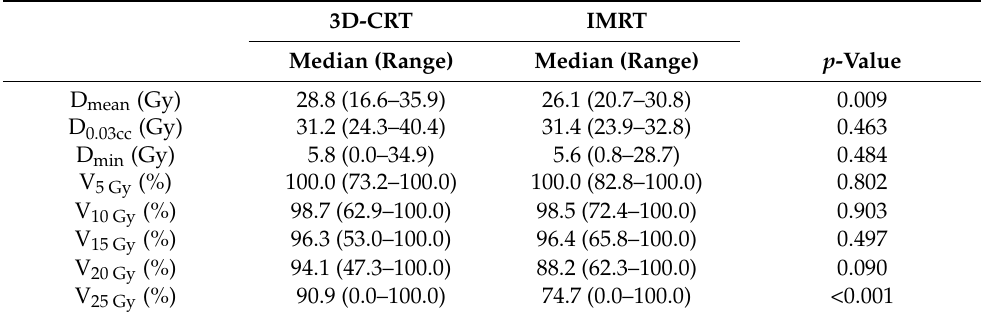
Table 2. Dosimetric comparison between three-dimensional conformal radiotherapy and intensity- modulated